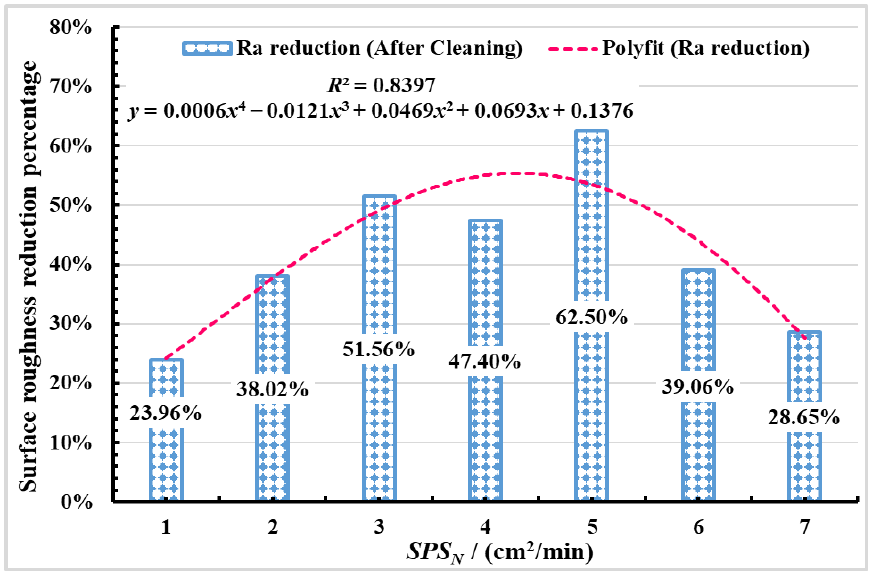
Figure 15. The relationship between the surface roughness Ra reduction percentage and SPS N . The original surface and polished surface of mold steel were observed by LSCM, and the surface roughness Ra; three-dimensional morphology and surface profile were obtained, as shown from Figures 16–18. It can be seen from Figure 16a that there are obvious crests and troughs on the original surface, and the surface profile is very irregular. The maximum value of the original surface roughness Ra is 1.98 µ m. Figure 16b shows that the original surface profile fluctuates greatly, and the surface crests and troughs are obvious. The height difference between crest and trough is large, and the original surface roughness is large.